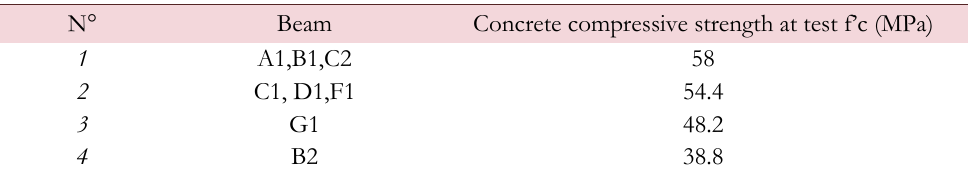
Table 1: Concrete compressive strength of the tested TCC beams[14].